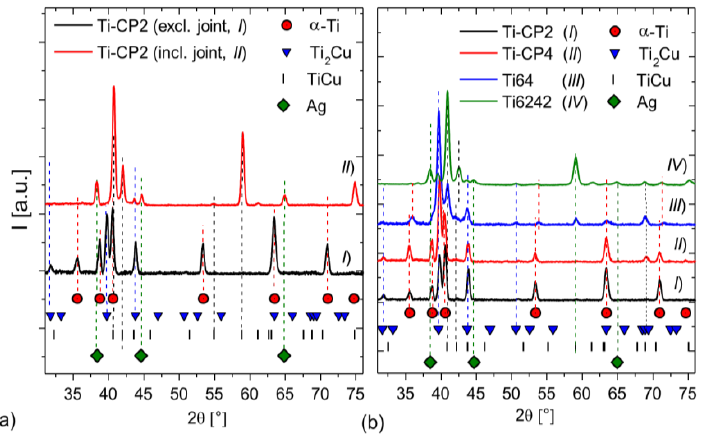
Figure 7. X-ray diffraction analysis: ( a ) Comparison of both fractured sample halves (excluding and including joint) for the Ti-CP2/Ag28Cu joint with the main identified phases. ( b ) Diffractograms of all investigated joints for the sample halves excluding the joint.